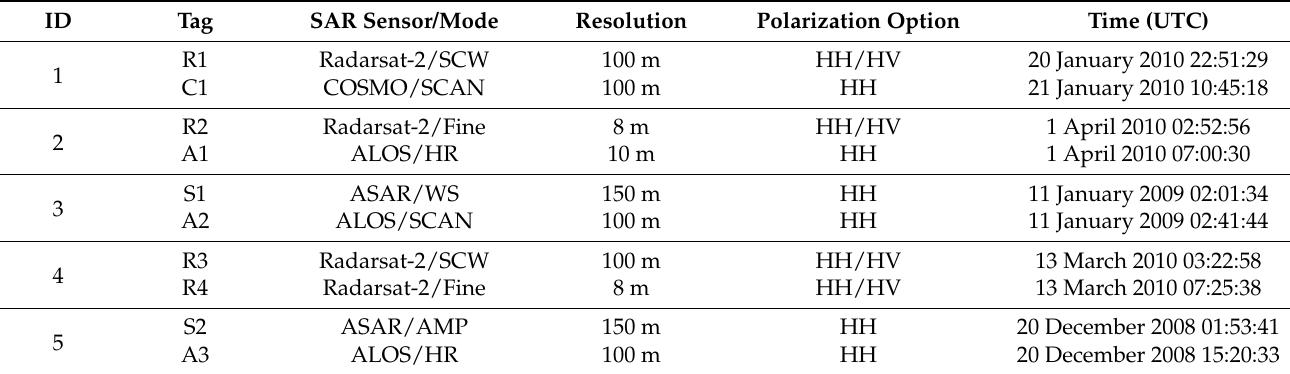
Table 1. The Basic Information of The SAR